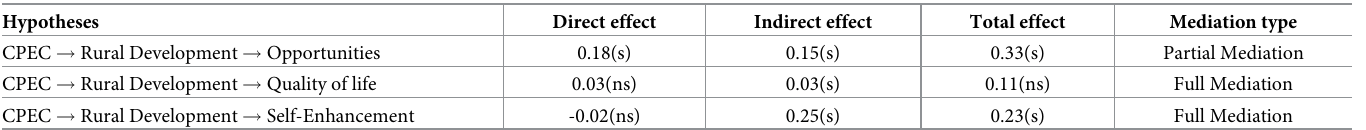
Table 8. Partial and full